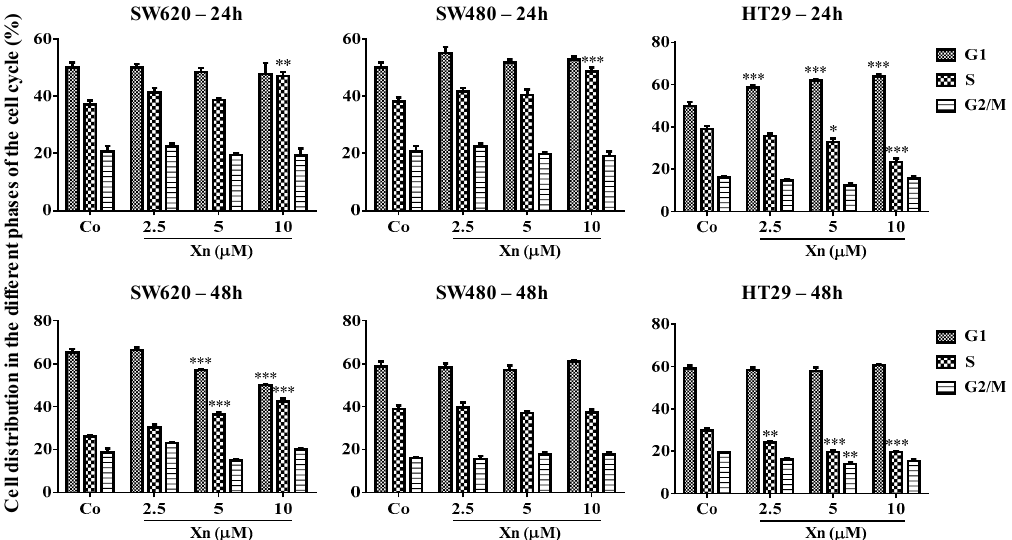
Figure 2. Effects of xanthohumol (Xn) on cell cycle distribution in colon cancer cell lines. After 24 h of culture, colon cancer cells SW620, SW480, and HT29 were treated with medium containing vehicle control (0.1 % DMSO; Co) or increasing concentrations of Xn (2.5, 5, and 10 µM) for 24 and 48 h. Cells were collected and analyzed by flow cytometry after staining with propidium iodide (PI). Histograms represent quantitative analysis of cell distribution in the cell cycle phases (mean ± SD of three independent experiments). p values were determined by a two-way ANOVA followed by Tukey’s multiple comparison test. * p < 0.05, ** p < 0.01, and *** p < 0.001.